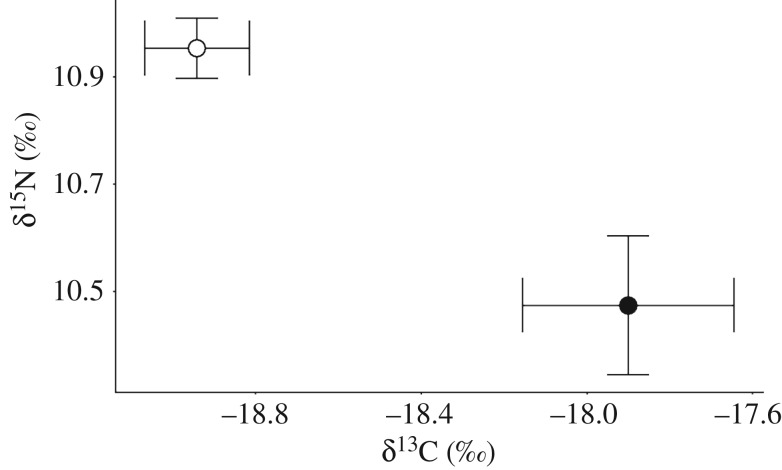
Isoscape of δ15N and δ13C values for reef manta ray (Mobula alfredi) muscle tissue collected in 2016 (black, n = 13) and 2017 (white, n = 36) at D'Arros Island, Seychelles.